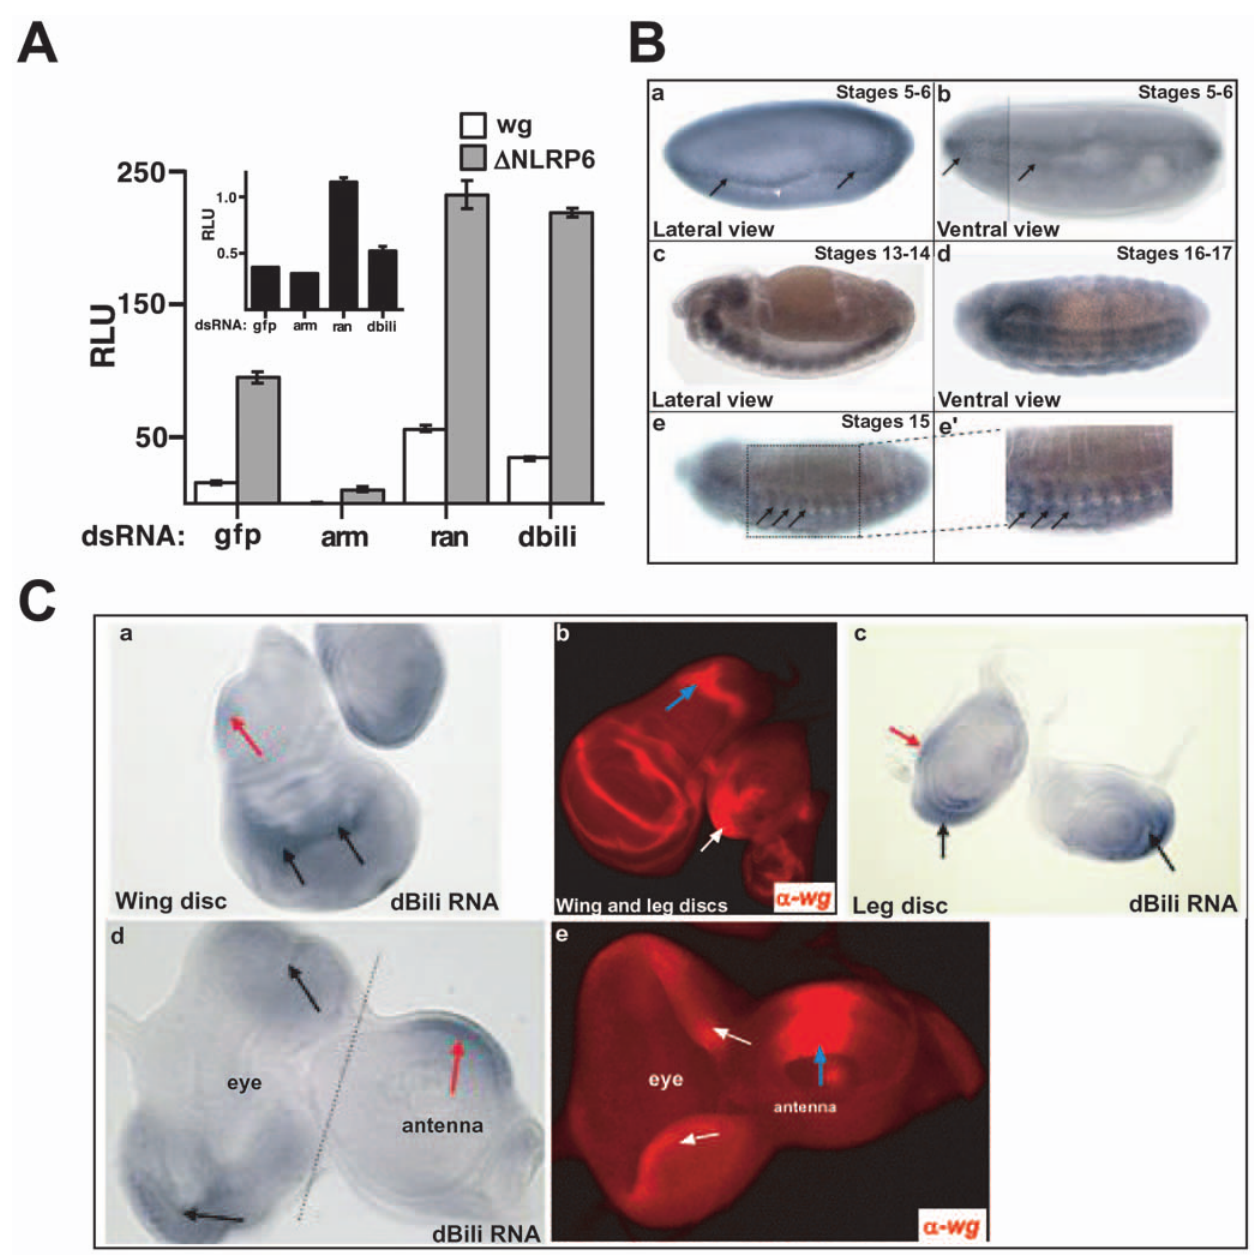
Figure 1. dBili (cg11848) is a negative regulator of Wg signaling. (A) Secondary reporter assay in clone 8 cells showing gfp, armadillo (arm), ran and dBili dsRNA effects on wingless (wg) (white bars) and D NLRP6 (gray bars) activation of b -catenin reporter, dTF12. Individual dsRNA effects on reporter activity in the absence of wg or D NLRP6 (inset). (B) Expression pattern of dBili mRNA by in situ hybridization. Embryos are oriented with anterior on the left and posterior on the right. (a & b) Stages 5–6 showing dBili expression in the neuroectoderm and cells adjacent to the ventral midline (black arrows) with high levels of expression in cells adjacent to the ventral furrow (white arrowhead). (c–e). At stages 13–17 the expression of dBili in the developing central nervous system (panel c & e) and the ventral epidermis in stripes (e & e’). At the end of embryogenesis (stage 16/17), the majority of dBili expression is restricted to the CNS (panel d). (C) (a & b) Wing imaginal discs. Panel a, shows dBili expression in the wing pouch (black arows) and in the notum/hinge area (red arrow). Panel b, staining for Wg protein in wing pouch and notum/hinge (blue arrow). (b & c) Leg imaginal discs. Panel c shows dBili staining in the ventral wedge (black arrows), identical to Wg expression (white arrow, panel b) (d & e) Expression in the eye disc of dBili (black arrows, d) and Wg (white arrows, e). Expression in the antenna disc of dBili (d, red arrow) and Wg (e, blue arrow).